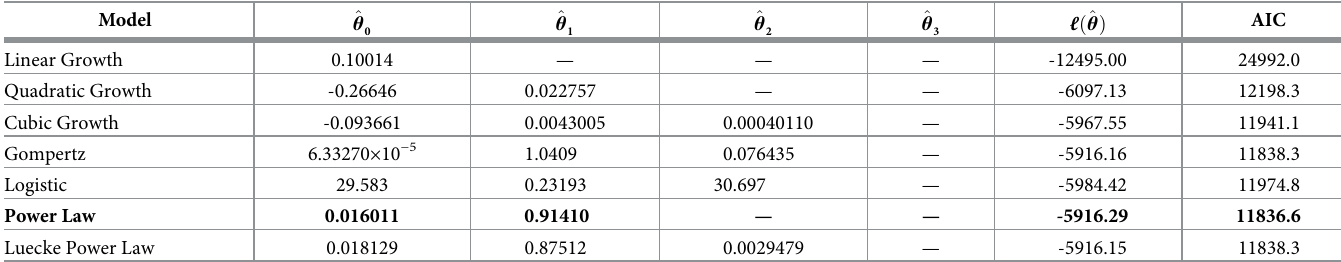
Table 20. Fetal kidney mass models (g vs. fetal mass in g for power law models, g vs. gestational age in weeks for all other models). Model